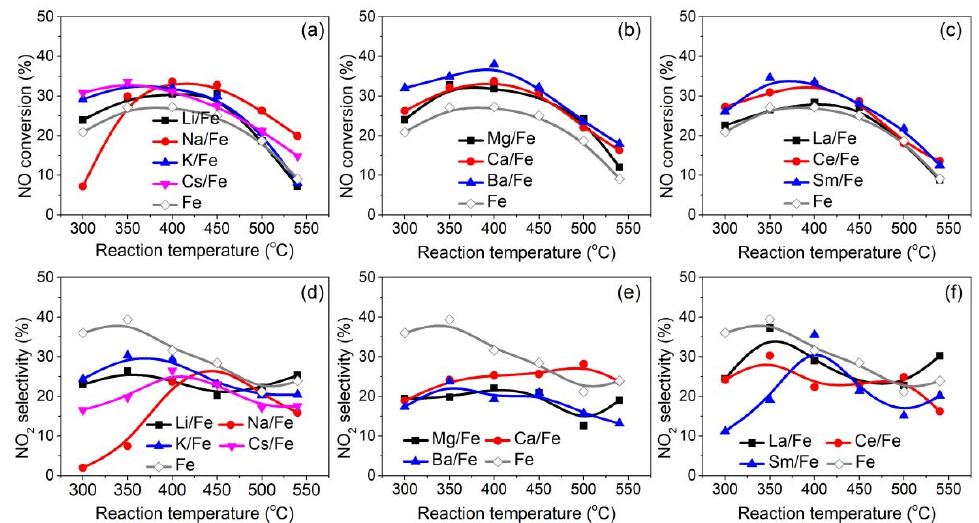
Figure 2. NO conversion and NO 2 selectivity of promoter-doped Fe-HZSM-5: ( a , d ) alkali metals; ( b , e ) alkaline earth metals; ( c , f ) rare-earth metals doping. NO = 1000 ppm, SO 2 = 500 ppm, O 2 = 10 vol.% with N 2 as balance gas, GHSV = 15,000 h − 1 .